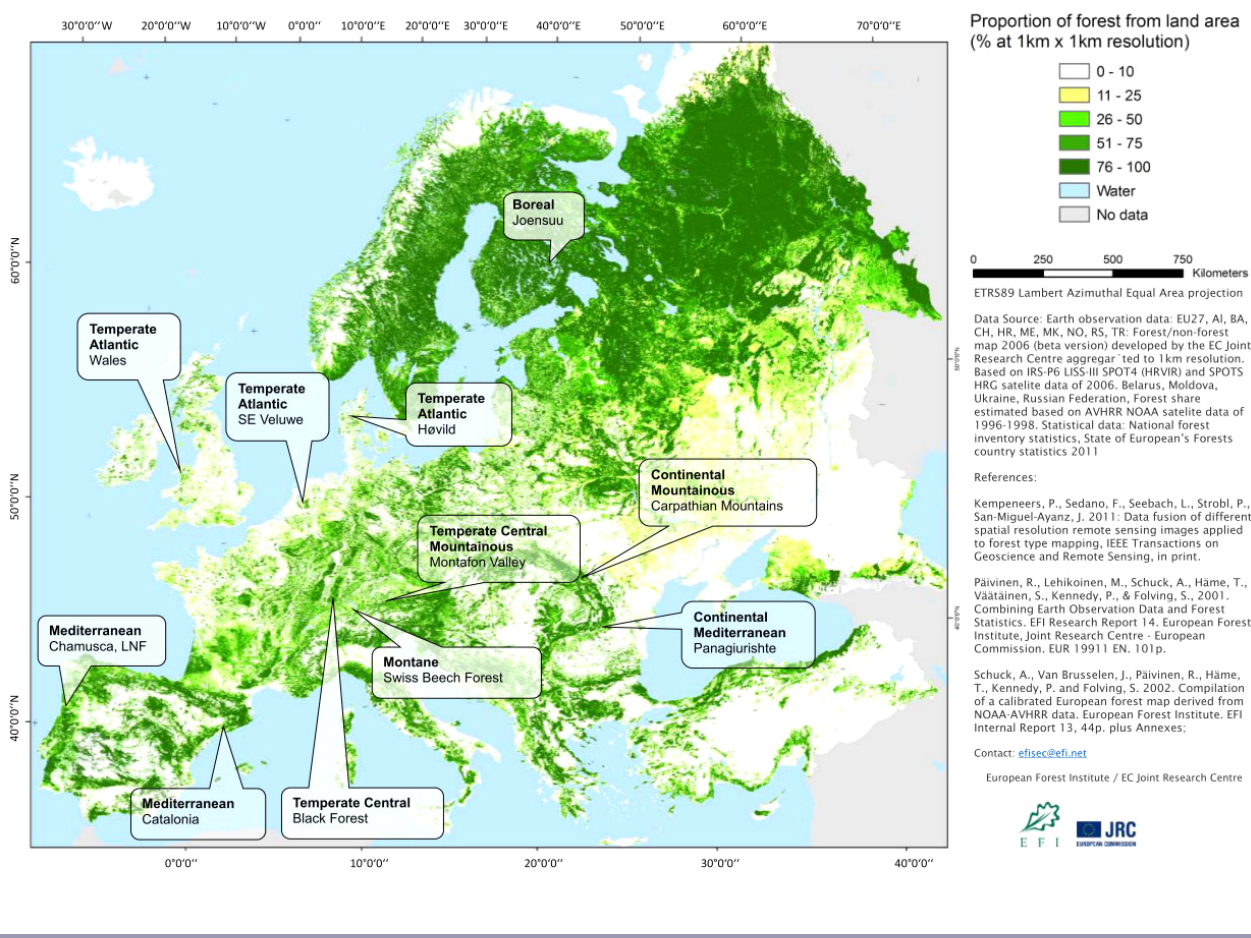
Fig. 1 . Case studies representing the diversity of European forests (Source: European Forest